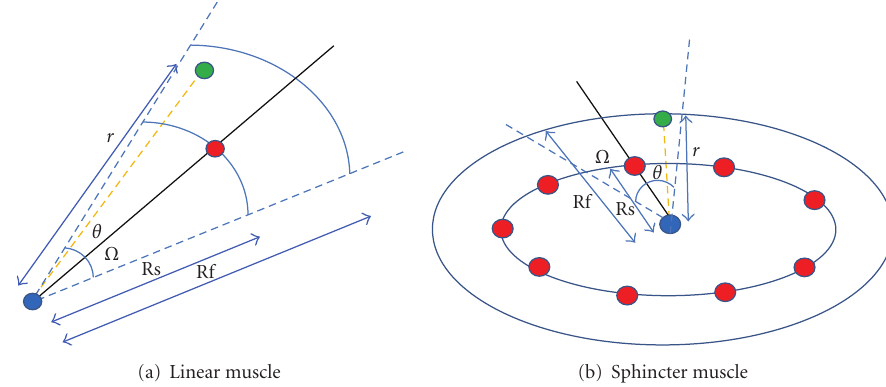
Figure 8: The blue vertex is the fixed bony attachment point, and the red vertex is the skin attachment point. The green vertex is a facial control point within the zone of influence. When the muscle contract, the red point is moved along the muscle endpoints. Rs: radial distant at the muscle’s registration, Rf: radial fall o ff distance, Ω : angular fall o ff , θ : angle of the control point from the muscle.